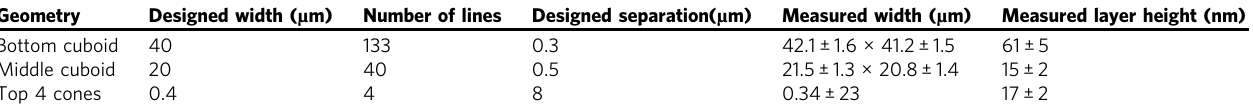
printing 40 lines with 500 nm separation. The four cones are cuboid. Each cone was produced by dispensing a droplet of liquid